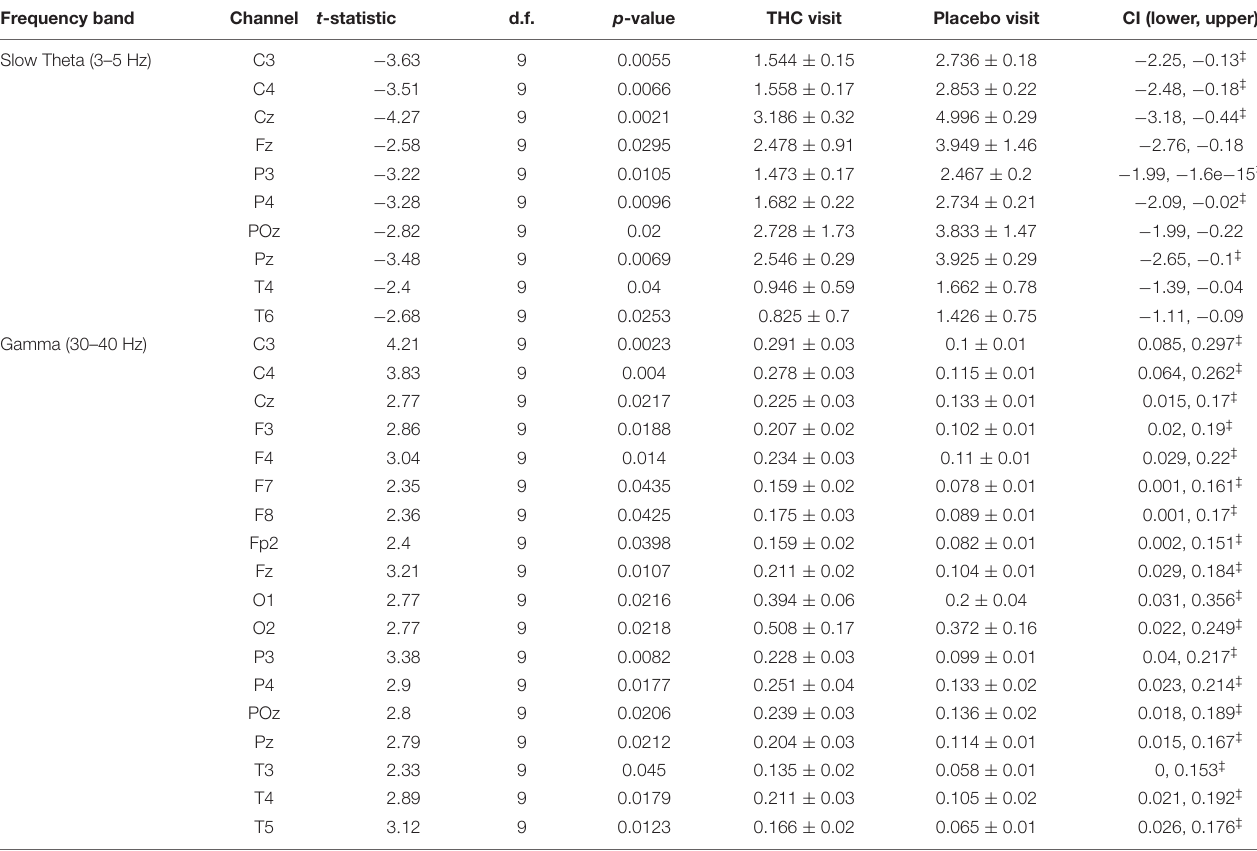
TABLE 1 | Paired t -test statistics for absolute spectral power during RSEC comparing the (cid:49) 9-THC and placebo condition. Frequency band Channel t